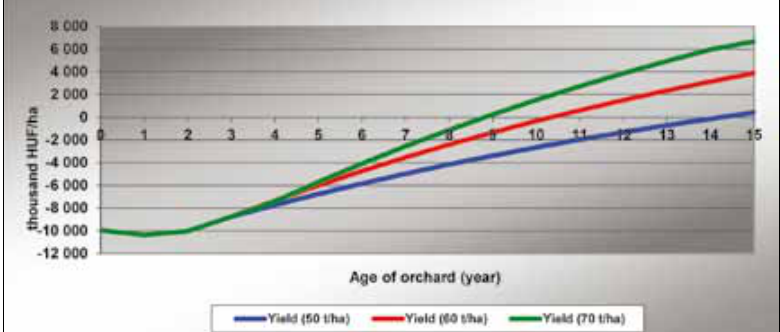
Figure 2: The Tendency of NPV in Superintensive Orchard during the Whole Lifetime in Case of Reaching Different Yield Levels in the Mature State . Source: own